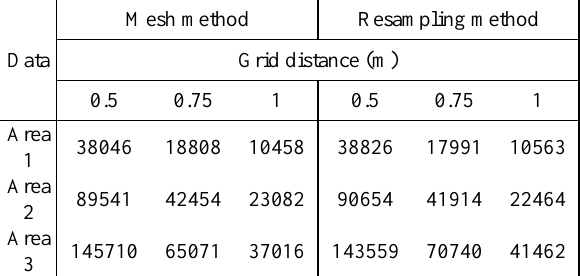
Table 2 . The number of grid points for each gridded area and each method.